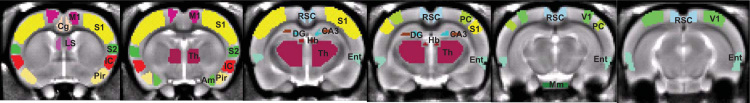
Location of ROI. The 34 ROIs chosen for calculating the correlation matrix and network plot.